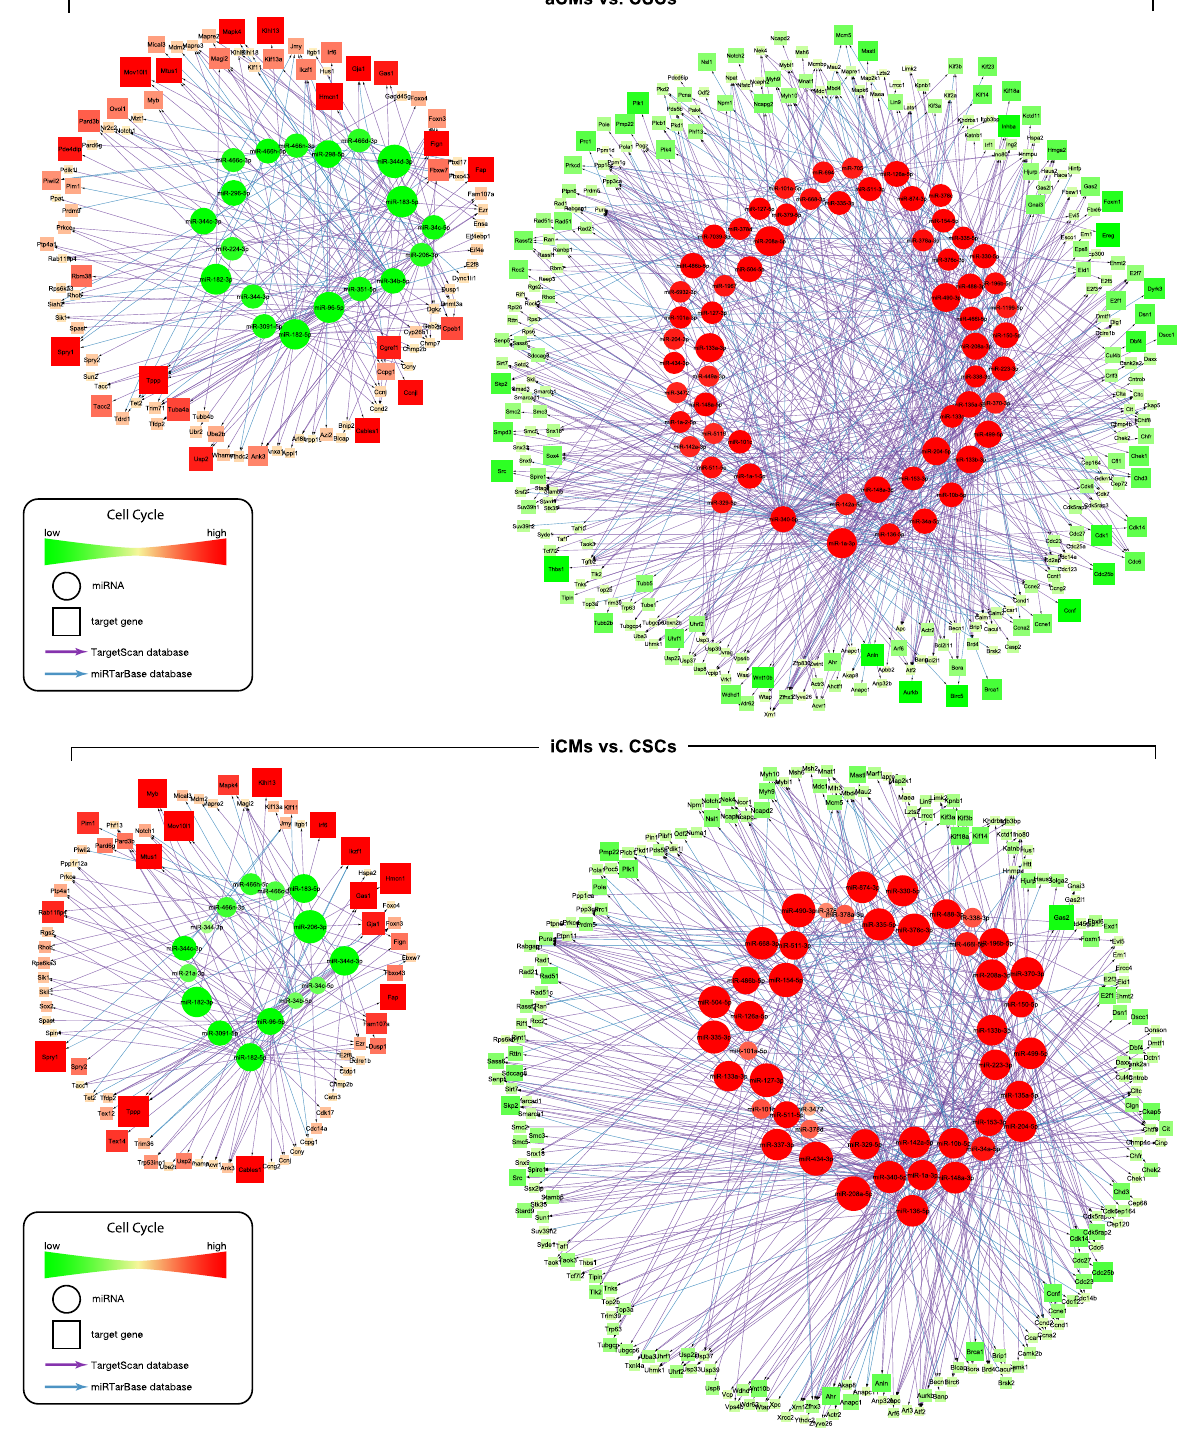
Fig. 6 miRNA/mRNA networks describing the process of cell cycle. The networks were built starting from the down-regulated (left) and up-regulated (right) miRNAs in the “ aCMs vs. CSCs ” (upper panel) and “ iCMs vs. CSCs ” (bottom panel) comparisons, respectively. The networks were developed inserting each microRNA mRNA target that was effectively up-regulated for the down-regulated miRNAs and each miRNA/mRNA target that was effectively down-regulated for the up-regulated miRNAs. Differentially expressed miRNAs were used as starting nodes to generate the interaction network of miRNAs and their targets. Each link connects the source (miRNA, circle) and its targets (mRNA, squares). The colors represent changes in expression (green as down-regulated, red as up-regulated). Subsequentially functional analysis of miRNA/mRNA networks was done for selected biological processes. All RNASeq data are representative of biological triplicates for CSCs and iCMs and of biological duplicate for aCMs. Each of the biological replicate was veri fi ed by a technical